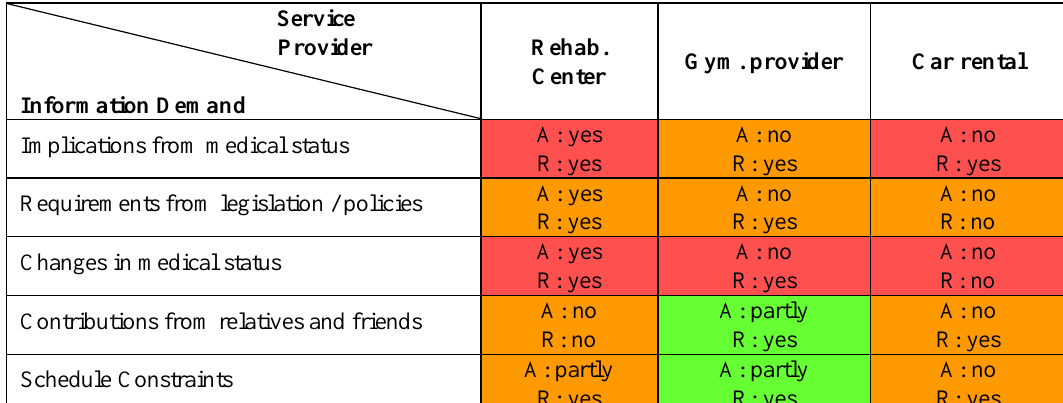
Table 3. Relevance of Information Demand for Service